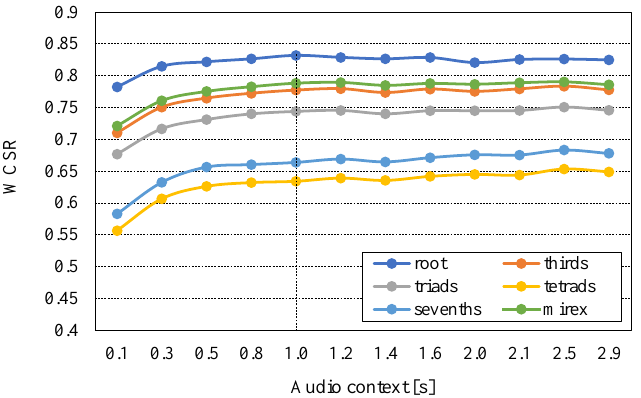
Figure 8. Validation WCSR for chord recognition of different scores based on different audio context sizes in the VGG-style CNN